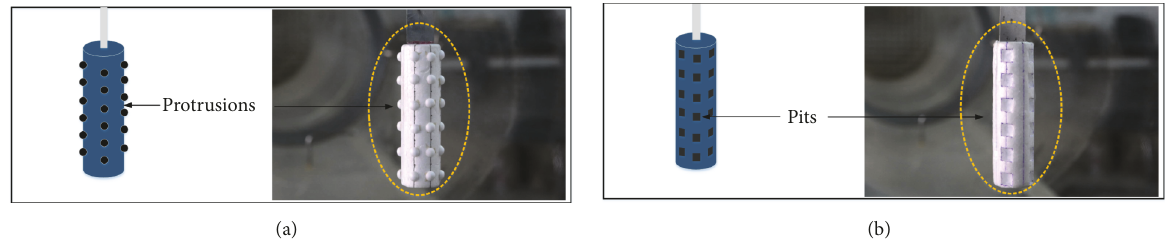
Figure 1: Physical model of bluff bodies with bionic structure. (a) Schematic of the protrusions; (b) schematic of the pits.